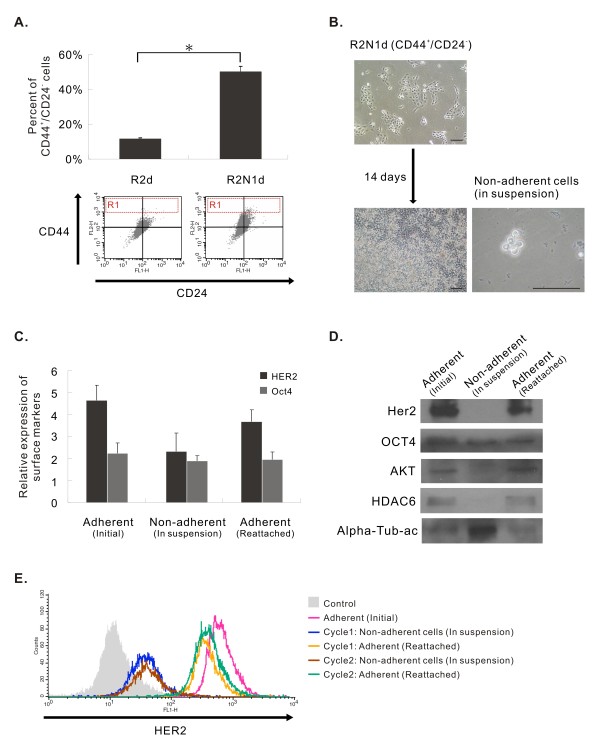
Expression of breast cancer stem cell markers CD44+/CD24-/low in R2d and R2N1d cells and Modulation of HER2, Oct-4, AKT and HDAC6 expression in R2N1 cells by cell culture condition. A, higher frequency of CD44+/CD24-/low cells was found in R2N1d cells than R2d cells (~50% vs. ~10%). R1 region denotes a small population of CD44high cells which was increased in R2N1d cells. The fluorescence cut off level: high expression was fluorescence intensity > 103; negative or low expression was fluorescence intensity < 102. B, CD44+/CD24- cells sorted by flow cytometry tend to show contact-insensitive growth in confluent culture and gave rise to non-adherent cells in suspension. By flow cytometric analysis (C, E), and by western blotting (D), adherent cells and re-attached cells were found to be HER2+/OCT4+/AKT+/HDAC6+, whereas non-adherent cells were HER2-/OCT4+/AKT -/HDAC6-. The length of the scale bar of these photos is 100 μm.